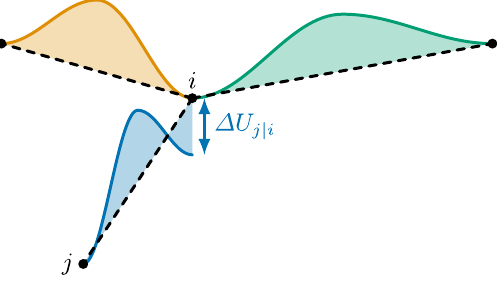
FIG. 13. Discontinuous potential. Local potential between state i three neighbor states. Along the leg from state i to state j the potential has a discontinuity of strength Δ U